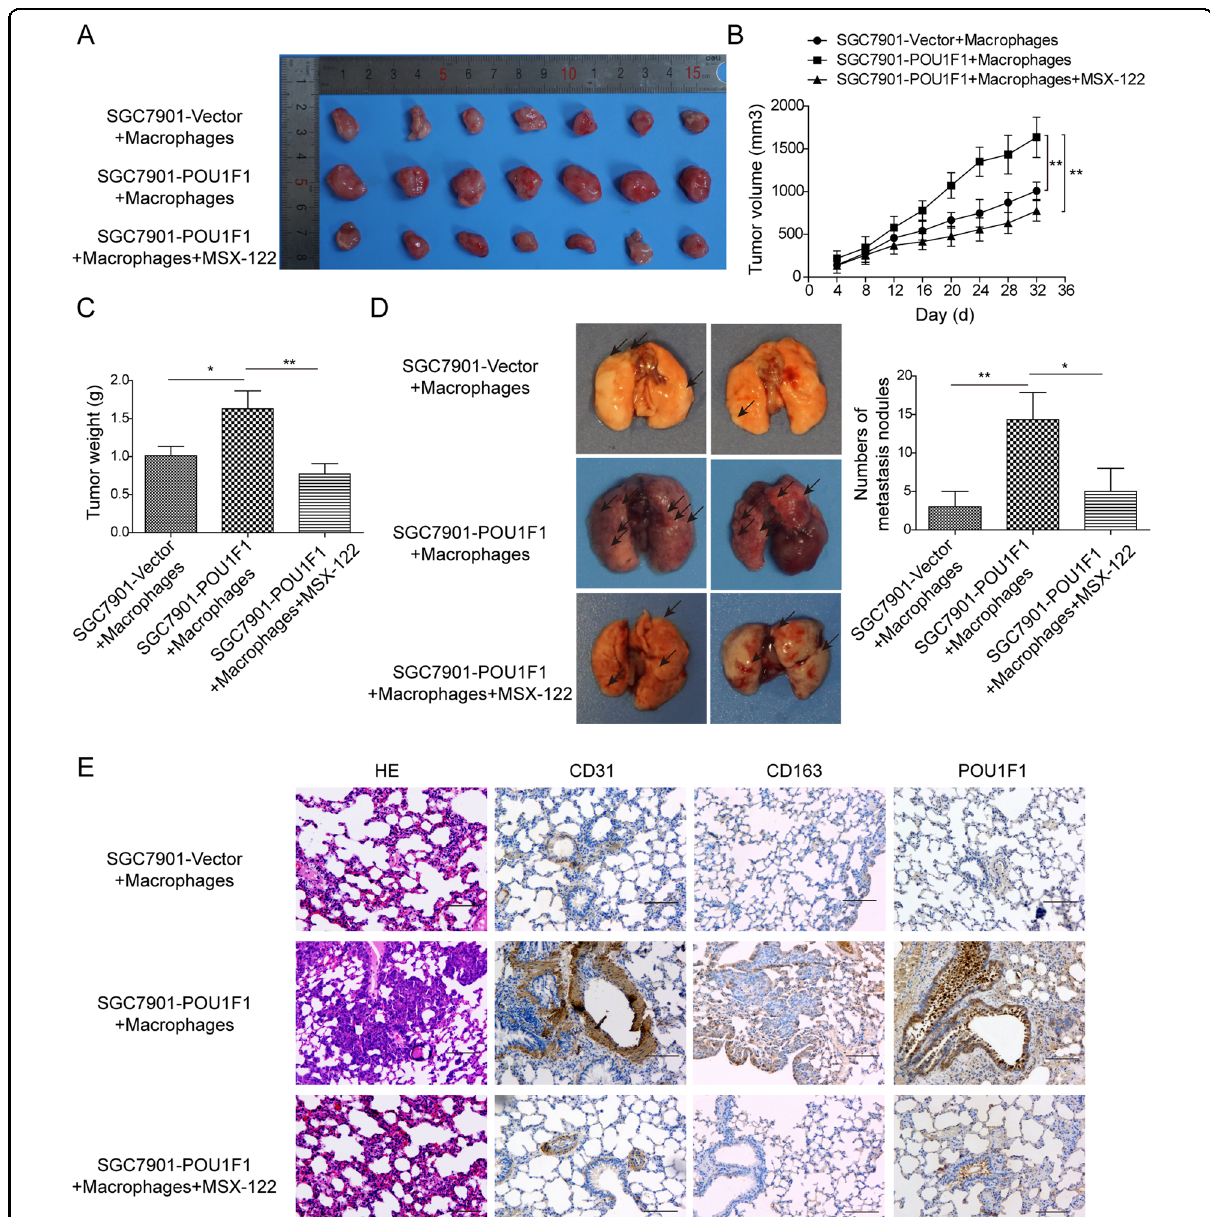
Fig. 7 POU1F1 promotes GC metastasis in lung by modulating macrophage polarization through CXCL12/CXCR4 axis. A The photos of xenograft tumors. B Quantitative analysis of tumor size. C Quantitative analysis of tumor weight. D The photos of lung tissues. Quantitative analysis of metastatic nodule numbers. E Histopathological analysis of metastatic nodules in lung. The histopathological changes were determined by H&E staining. The immunoreactivities of CD31, CD163, and POU1F1 were assessed by IHC